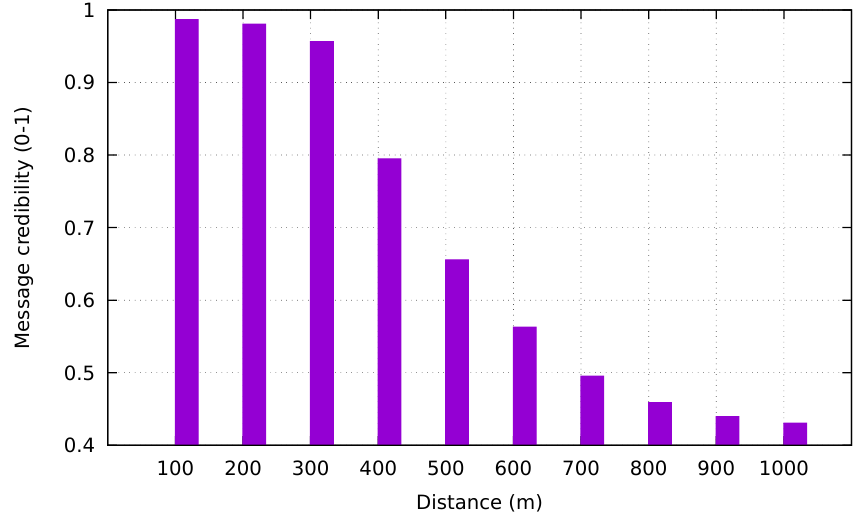
Figure 8. Message credibility rating versus distance of V P to occurred event.